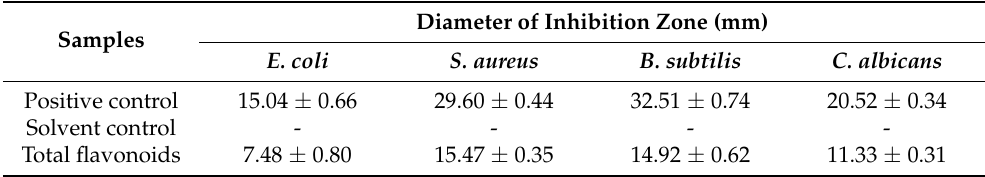
Table 4. Diameter of inhibition zone of total flavonoids from perilla leaves.